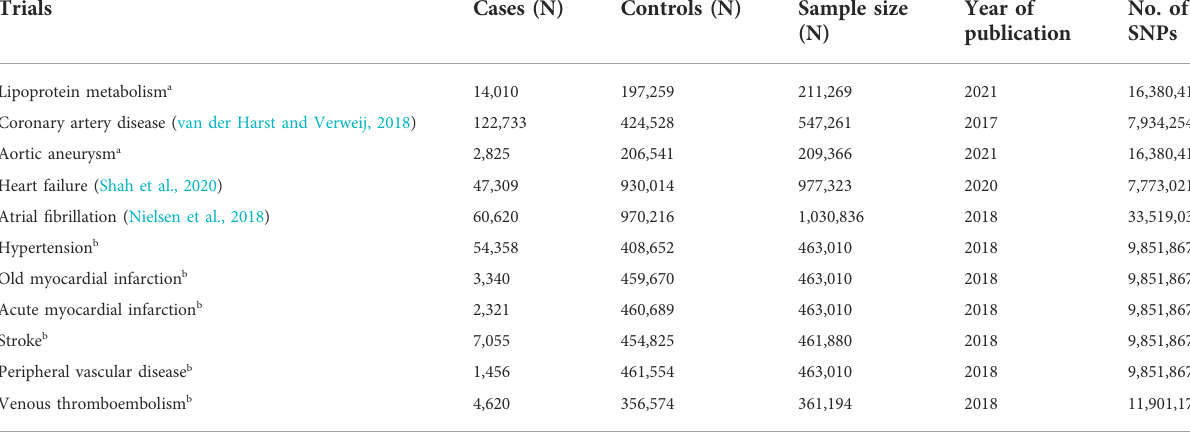
TABLE 1 Characteristics of selected GWASs.